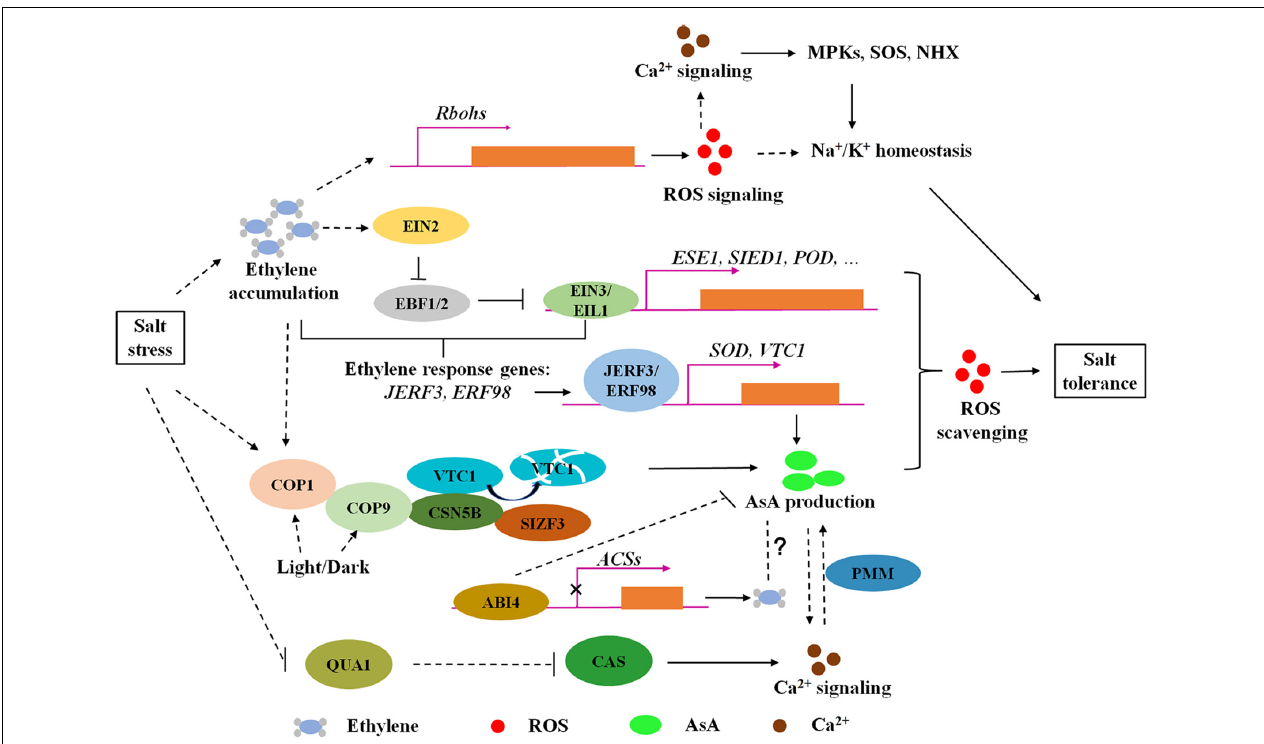
FIGURE 1 | The modulation of ethylene signaling and AsA biosynthesis regulators on ROS homeostasis in response to salt stress. Ethylene is accumulated and plays dual roles in ROS homeostasis under salt stress. On one hand, ethylene promotes ROS production to active Na + and K + transport through upregulating Rbohs gene expression. In the other hand, salt stress enhances EBF1/EBF2 degradation through EIN2C-dependant translational regulation to increase EIN3/EIL1 protein levels, activating gene expression of EIN3 direct binding targets ( ESE1, SIED1, and POD ) and ethylene response factors ( JERF3 and ERF98 ) to regulate salt tolerance via ROS scavenging. ERF98 positively regulates salt tolerance via transcriptional activation of AsA biosynthesis gene VTC1 . Moreover, CSN5B, a subunit of photomorphogenic COP9 signalosome, contributes to AsA biosynthesis and salt responses due to modulation on VTC1 degradation. SIZF3 also confers salt tolerance through mediating the interaction between CSN5B and VTC1. This research indicates that ROS accumulation under salt stress could be eliminated through enzymatic and non-enzymatic pathways, in both of which ethylene signaling is involved. However, the understanding of ethylene roles in AsA biosynthesis is yet limited. ABI4 negatively regulates ethylene synthesis and AsA production, which supply a possible mechanism coordinating ABA and ethylene to regulate AsA biosynthesis under salt stress. Ca 2 + signaling could be induced by both ROS signaling and participates in AsA biosynthesis modulation through PMM. Arrows and lines with bars indicate activation and inhibition, respectively. Dotted lines indicate indirect